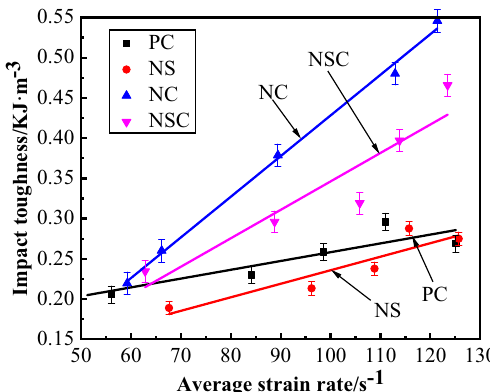
Figure 17. Relationship between impact toughness and average strain rate of